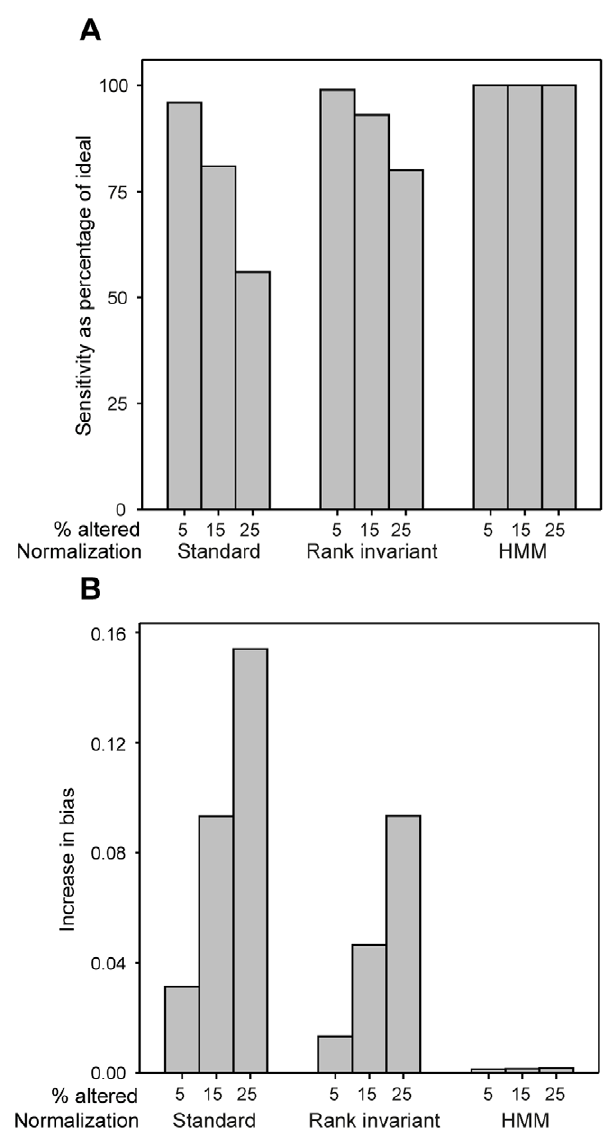
Figure 4. The performance of the HMM-assisted normalization. Comparison of the performance (sensitivity and bias) of the HMM, rank invariant and standard quantile normalizations relative the ideal quantile normalization evaluated on data simulated from skewed experiments. Three different percentages of altered variables (% altered) were considered (5, 15 and 25%). The experiments contained data from two treated samples and two reference samples, each with 100,000 variables. The altered variables were positively affected, with an effect size d =1.5 and was distributed in homogeneous regions including 50 altered probes ( i.e. m =50). A variable with an average M-value above the cut-off was called altered. For each experiment, the estimated sensitivity and bias was based on 10 simulated data sets. (A) The relative sensitivity for the HMM, invariant and standard quantile normalizations. Here, the relative specificity for the HMM, invariant and standard quantile normalizations was close to 100% for all considered parameter settings. (B) The difference in bias between the HMM, invariant and standard quantile normalization compared to the ideal quantile